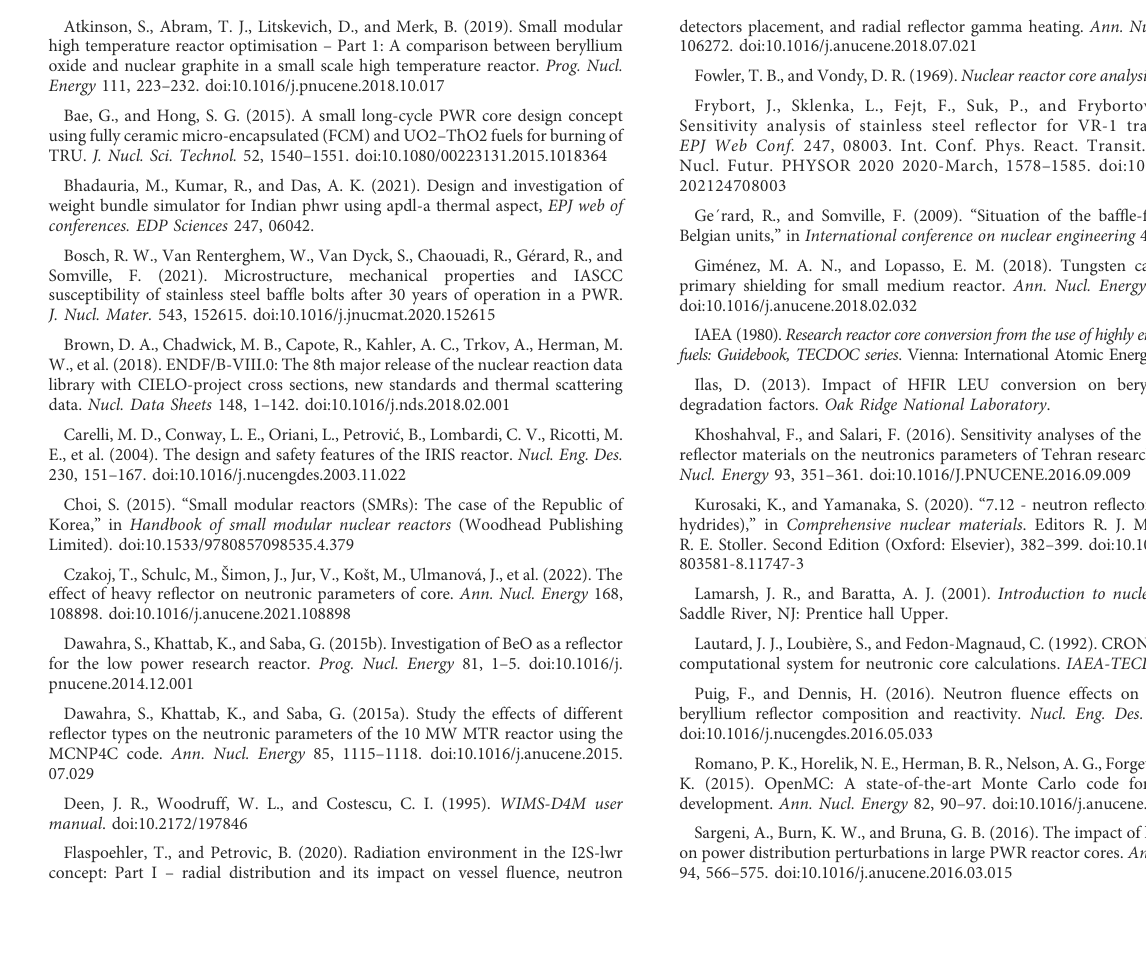
SUPPLEMENTARY FIGURE S1 OpenMC full core model with two-batch refuelling scheme and twelve burn-up zones spatial division. SUPPLEMENTARY FIGURE S2 Power distributions of two-batch refuelling scheme core with particular material re fl